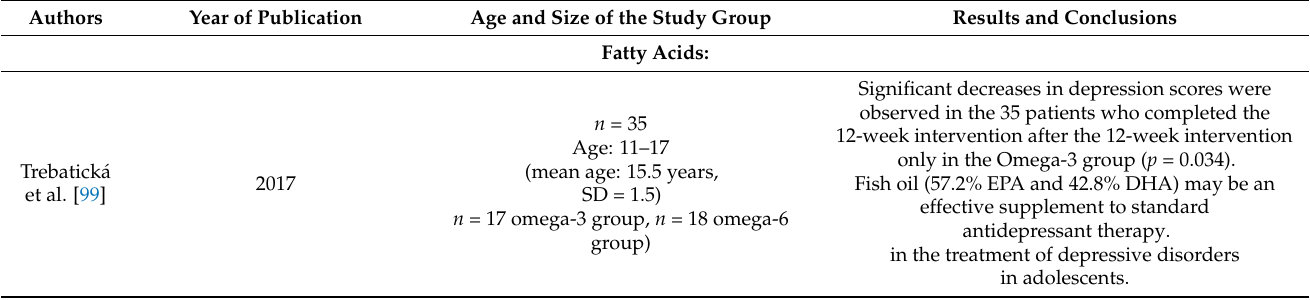
Table 3. Polyunsaturated fatty acids in the diet of children and adolescents in adolescent